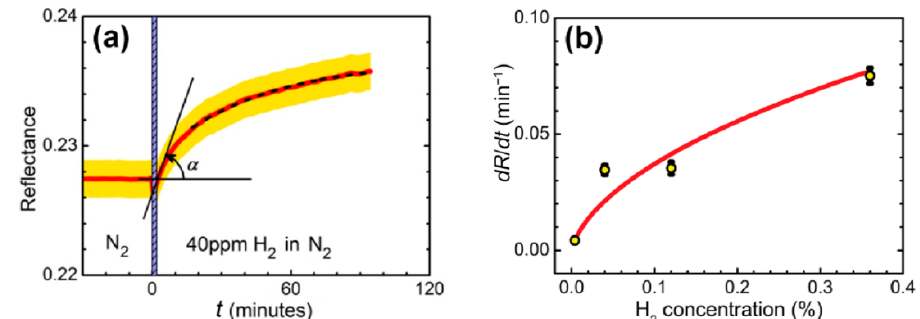
Figure 2. ( а ) Reflectance dynamics of sensing element exposed to 40 ppm hydrogen in nitrogen. The measurements were performed at the wavelength of 705 nm and angle of incidence of 42.5°. Red line—experimental data, yellow stripe—estimated measurement error. The dashed line is an exponential fit. Hydrogen is supplied at t = 0 min, the vertical shaded stripe width shows the stabilization time of the gas stand. ( b ) Dependence of the response of the WO 3 -based sensing element on the hydrogen concentration. Hydrogen concentration: 0.004% − 0.36%, carrier gas: nitrogen. The line shows the approximation based on the response model with the formation of tungsten bronzes in accordance with expression (1) from [38] .